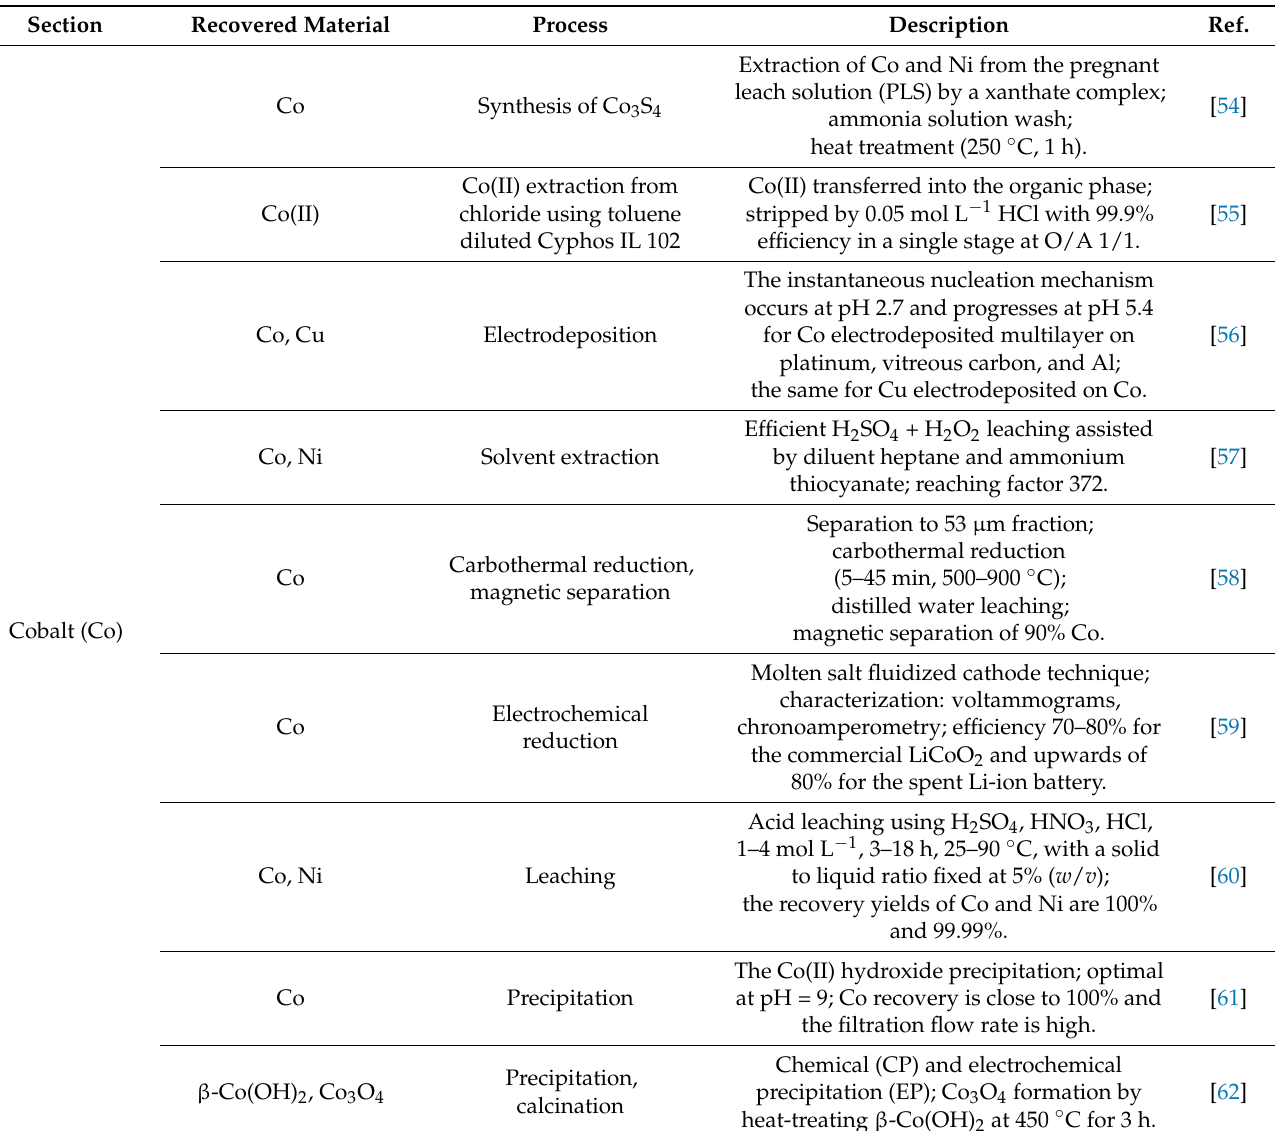
Table 5. Overview of the currently used recycling processes and recovery